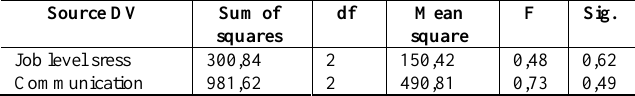
Table 2: MANOVA for the effects of job level on sources of stress and communication satisfaction